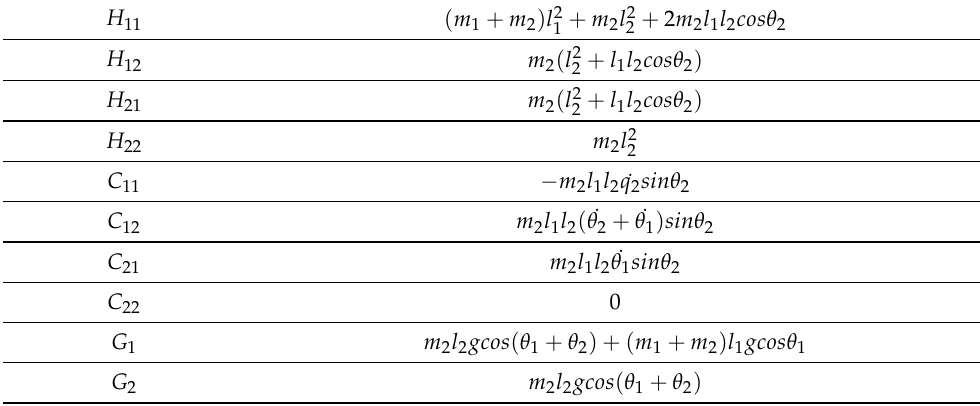
Table 1. The description of the 2-joint